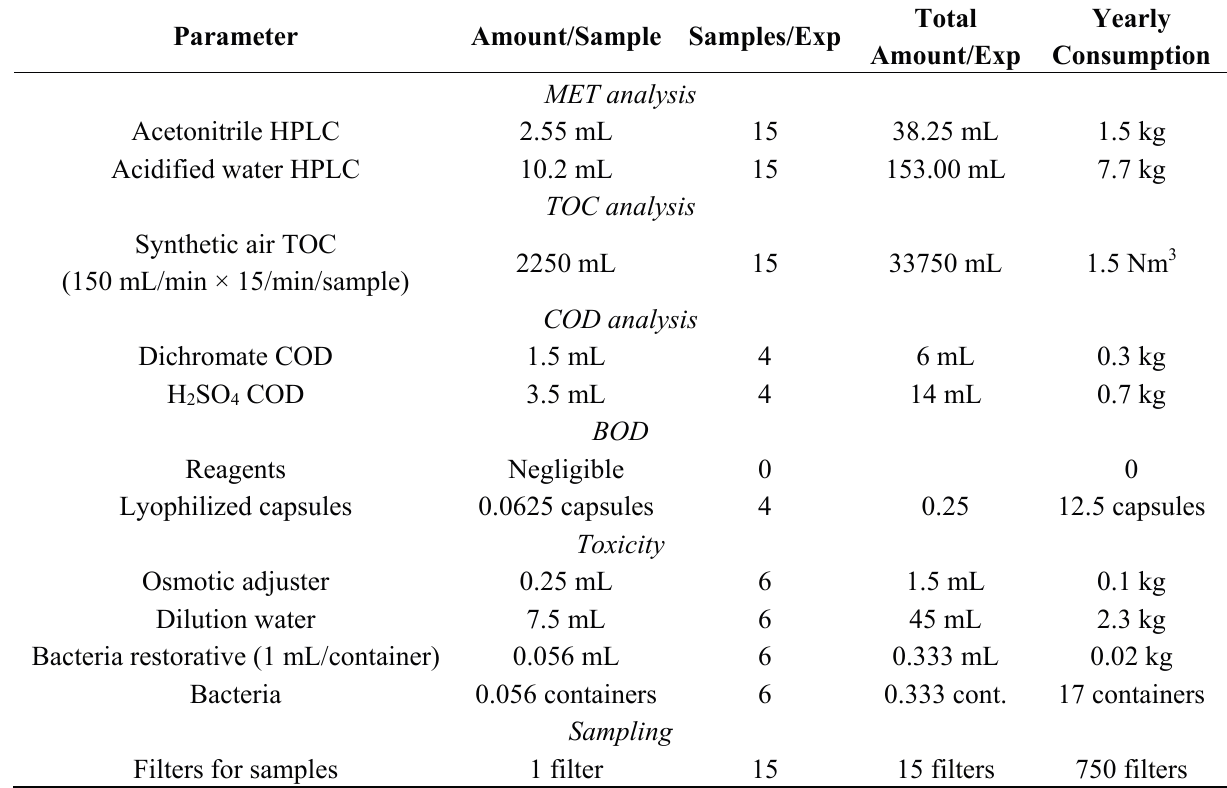
Table 7. Reagent consumption in the analysis of photocatalytic experiments for 50 experiments/year.